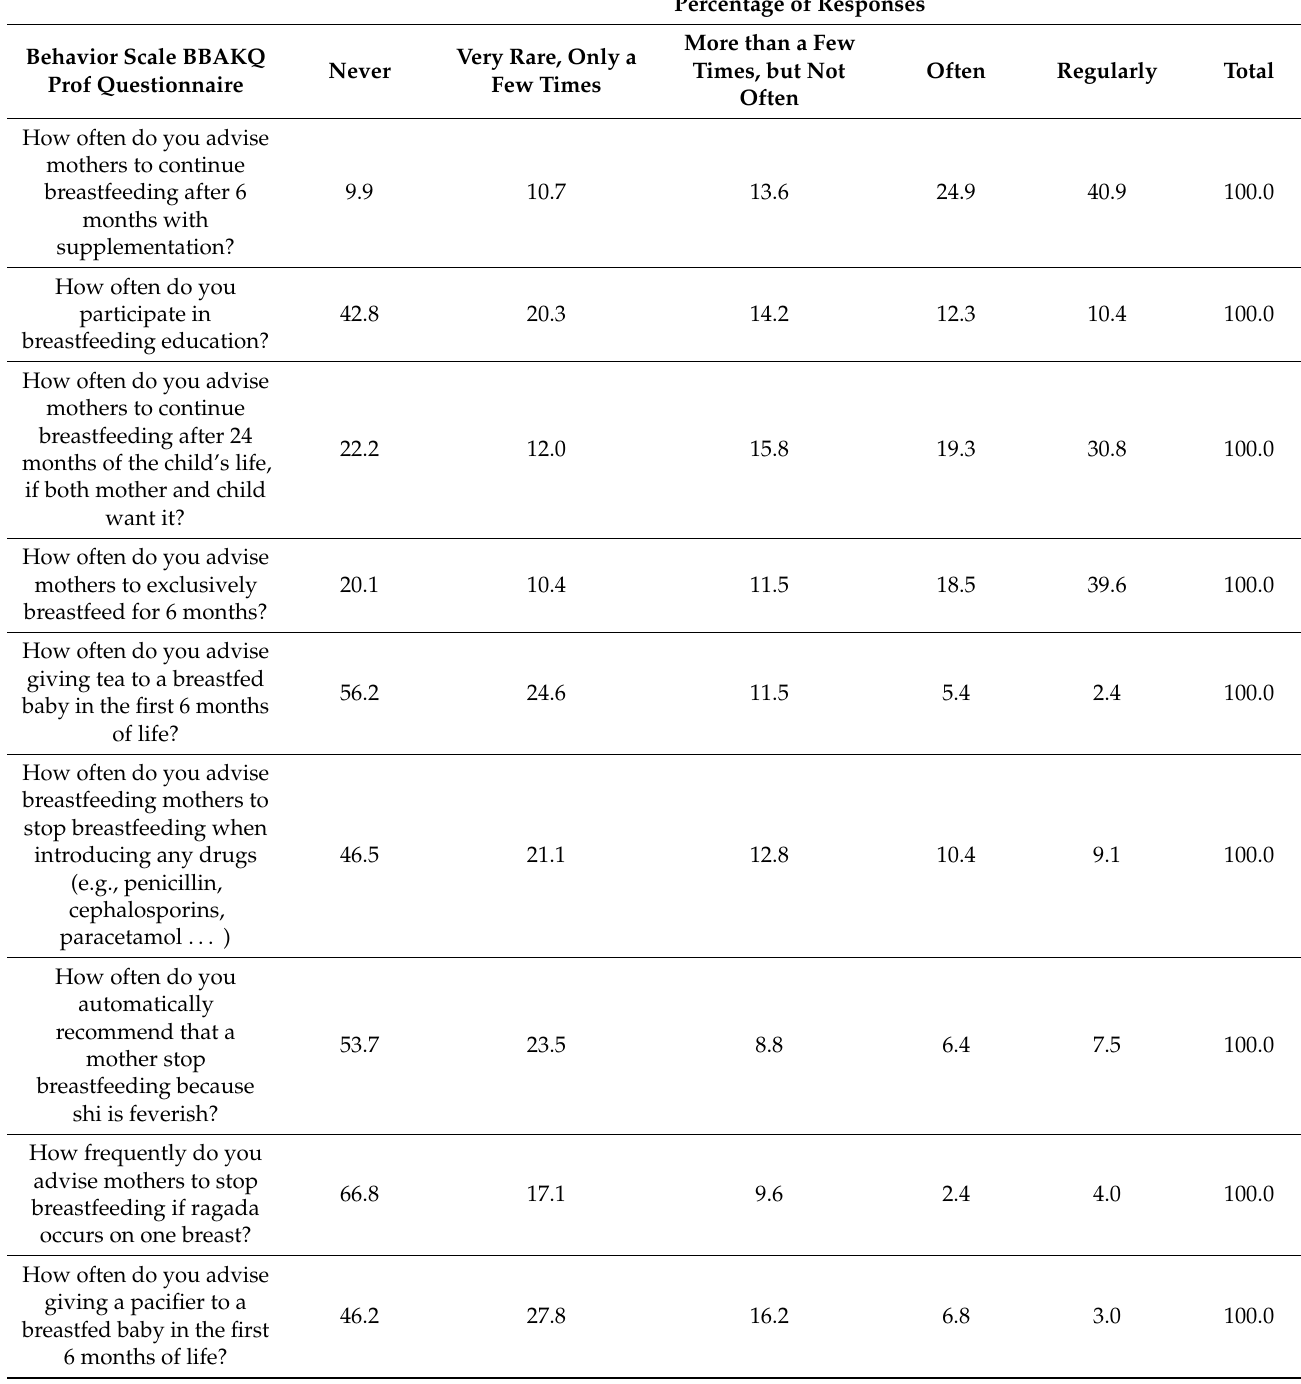
Overview of the respondents’ answers to the behavior scale BBAKQ prof questionnaire (N =